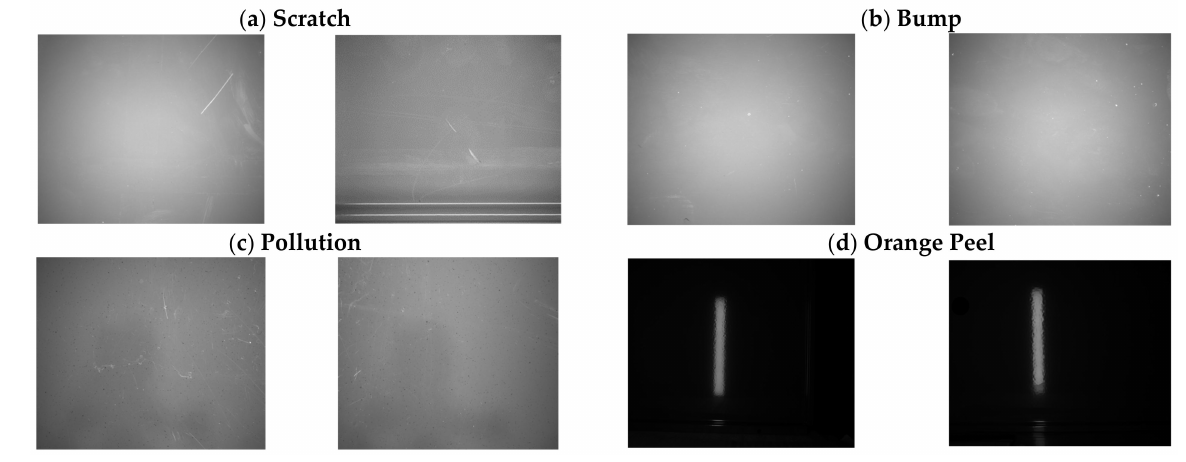
Figure 6. Defect Sample types for Red Color Products.